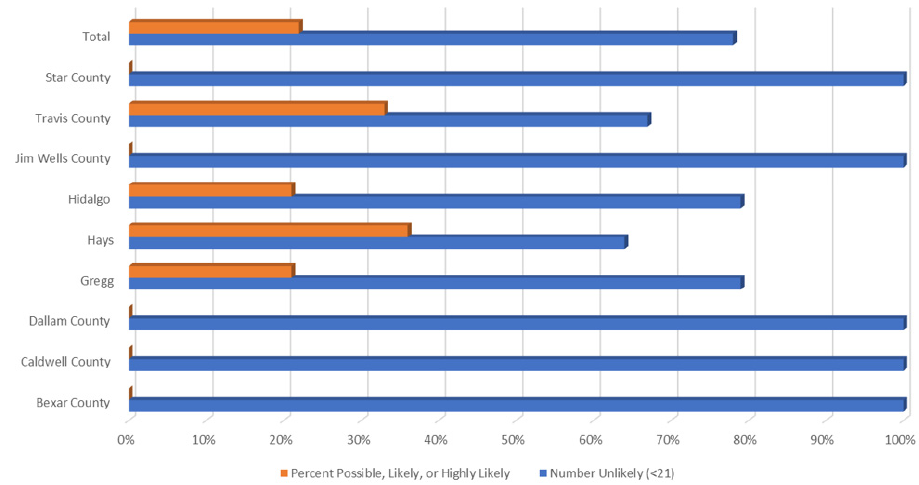
Figure 5. Percentage possible, likely, or highly likely, or not likely to have a TBD by county